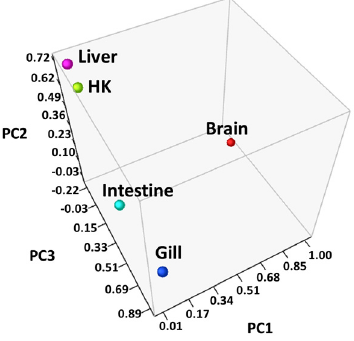
Figure 1. Venn diagram of gene sets in common carp treated under hypoxic conditions: Overlapping 22 genes in five organs are shown in the center, and each organ-specific gene is shown in the corners. HK: head kidney.